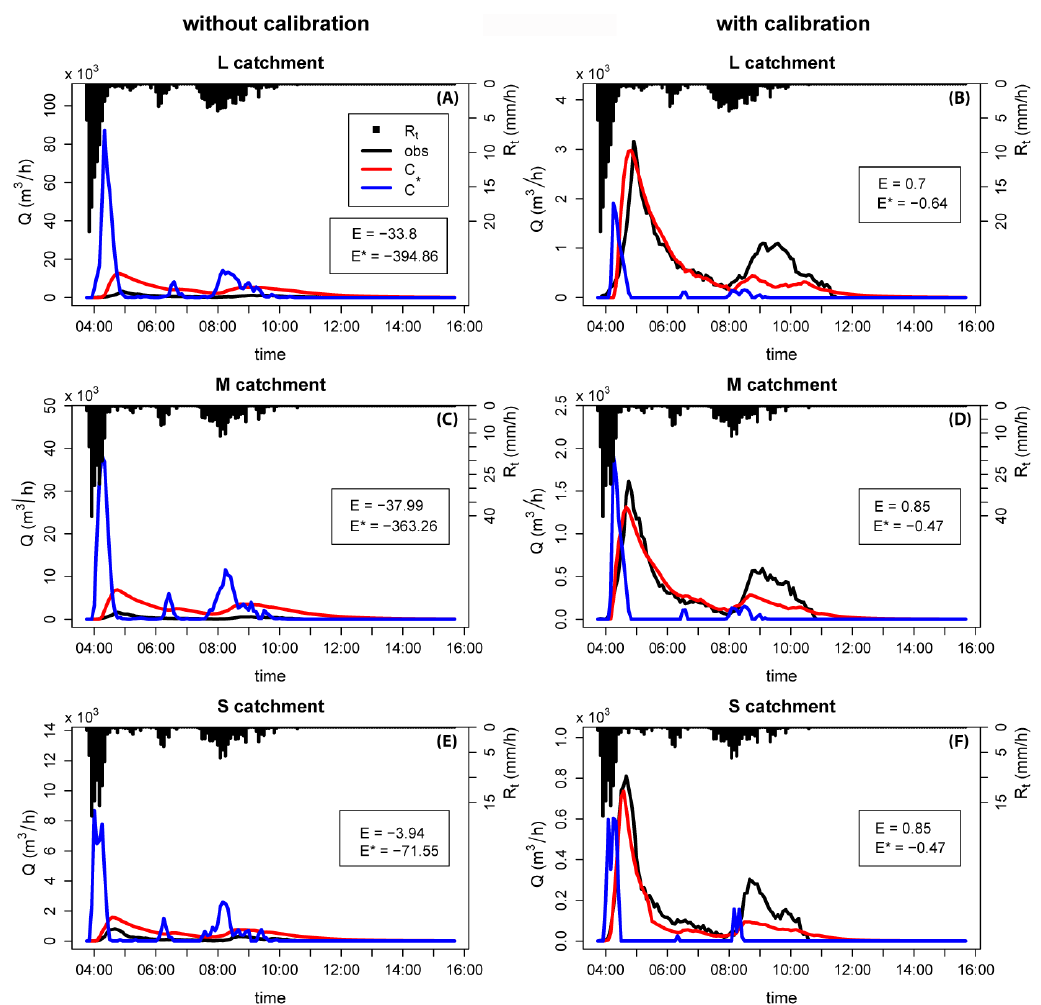
Fig. 7. Hydrographs ( Q , m 3 h − 1 ) modelled using the closure relation C (red) and C ∗ (blue) and observed (obs, black), for an event on 17 June 2010. Rainfall intensity ( R t , mmh − 1 ) is shown on the secondary axis. E and E ∗ are the Nash–Sutcliffe indexes for the closure relation C and C ∗ , respectively. Left (A, C, E) panels, without calibration; right panels (B, D, F) , with